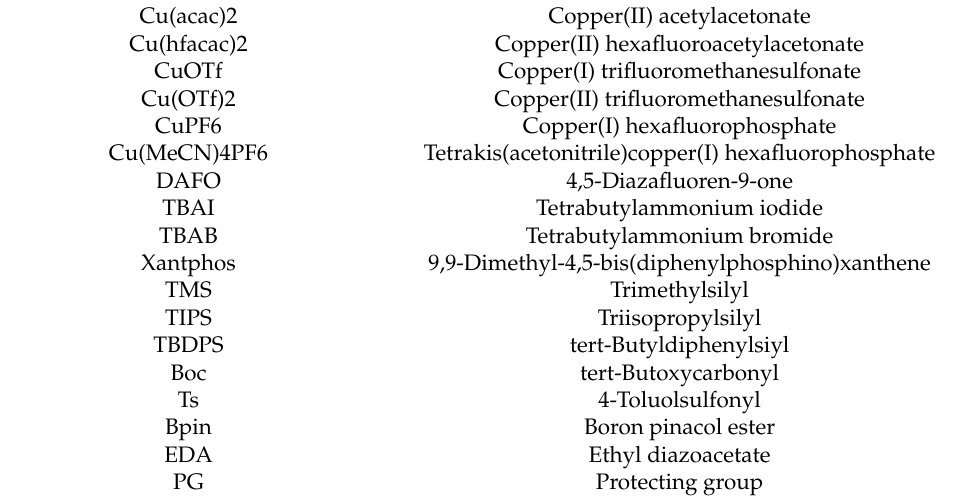
Table A1. The following abbreviations are used in this